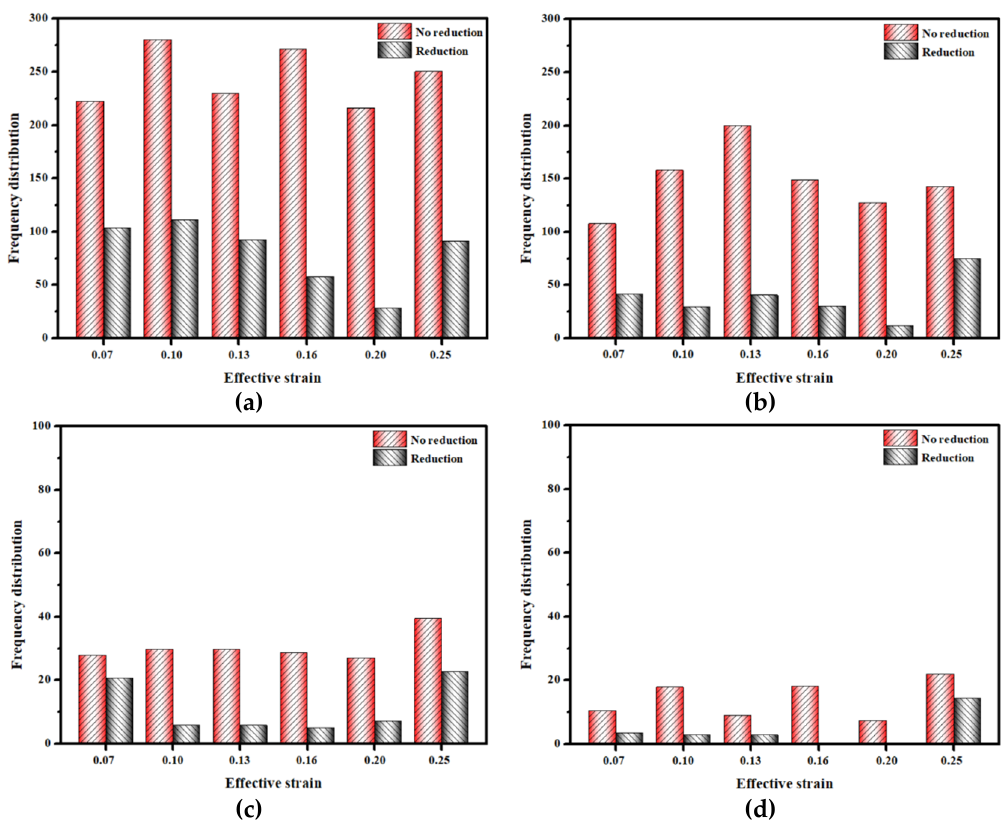
Figure 11. Distributions of porosities in the specimens: ( a ) the number of porosities with a diameter between 0.2 and 0.3 mm; ( b ) the number of porosities with a diameter between 0.3 and 0.4 mm; ( c ) the number of porosities with a diameter between 0.4 and 0.5 mm; ( d ) number of porosities with a diameter more than 0.5 mm.